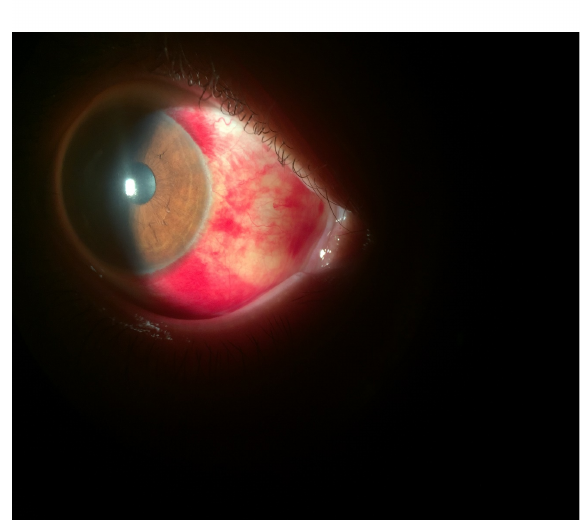
Figure 2: Slit-lamp image of the patient’s right eye 1 week after the onset of menstruation shows that the subconjunctival hemorrhage is beginning to clear.